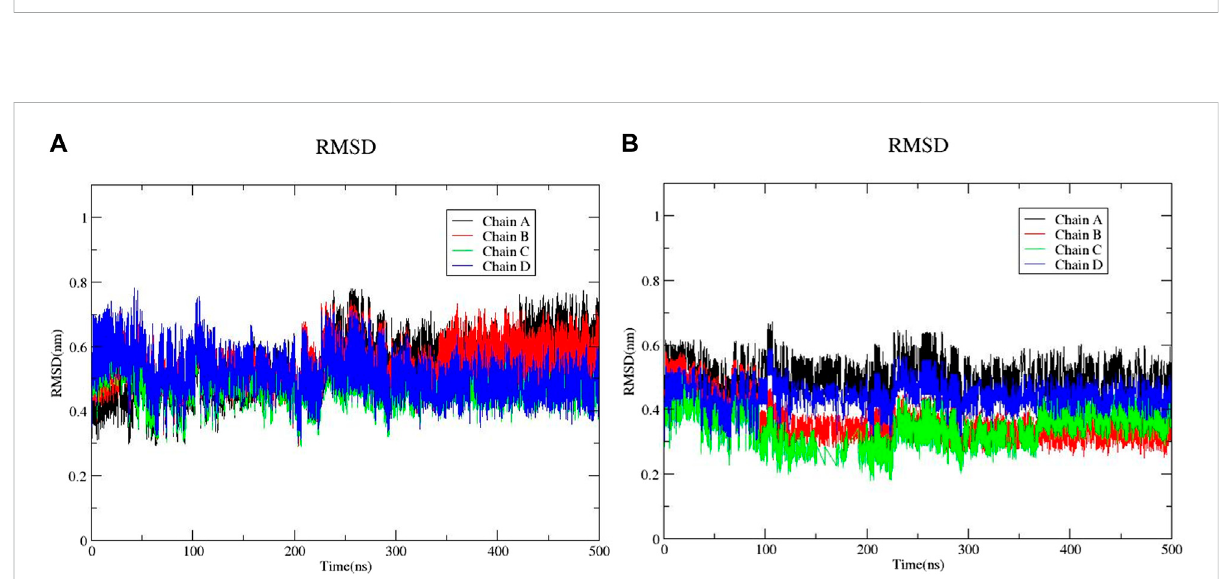
FIGURE 6 Tetrameric forms of hIMPDH1 (A) and hIMPDH2 (B) in complex with Zinc355749373 ligand (solid green). The IMP site of each monomer individually interacts with this